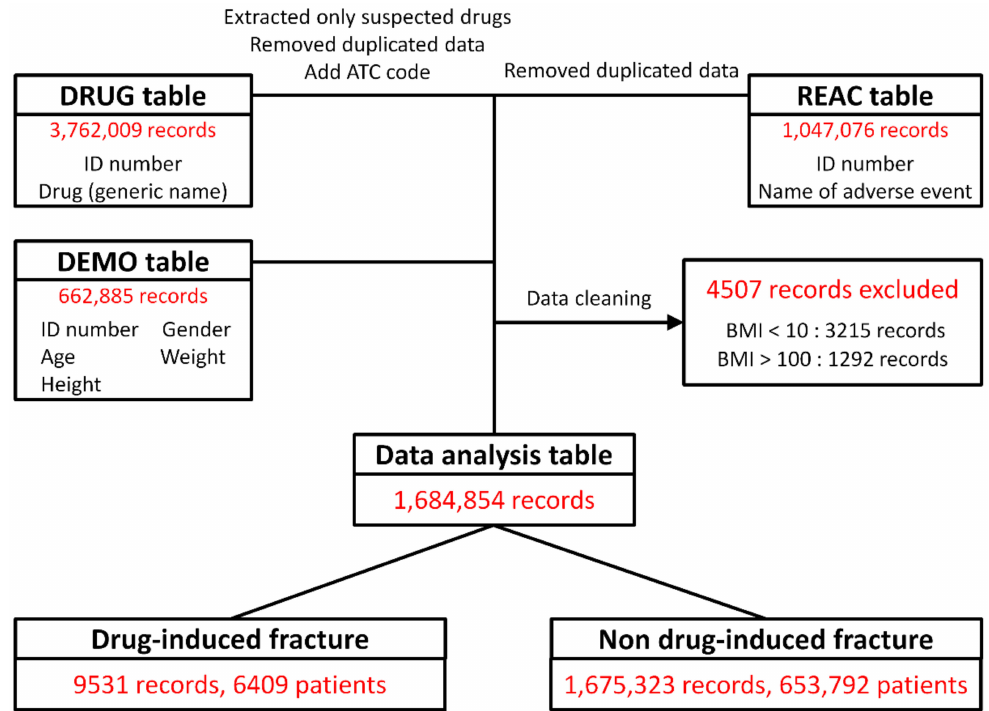
Figure 1. Flowchart for construction of the study cohort for data analysis. Causes of drug-related fracture for each drug in the DRUG table (drug name, causality) were classified into three categories: “suspected drug,” “concomitant drug,” and “interaction drug.” Only data in the “suspected drug” category were extracted. Data duplicated in the DRUG and REAC tables were removed [7]. Data in the DEMO table (patientcharacteristics such as sex, age, and weight) were combined with the DRUG and REAC tables using patient identification numbers. Cases involving patients with a body mass index (BMI) of <10 or >100 were